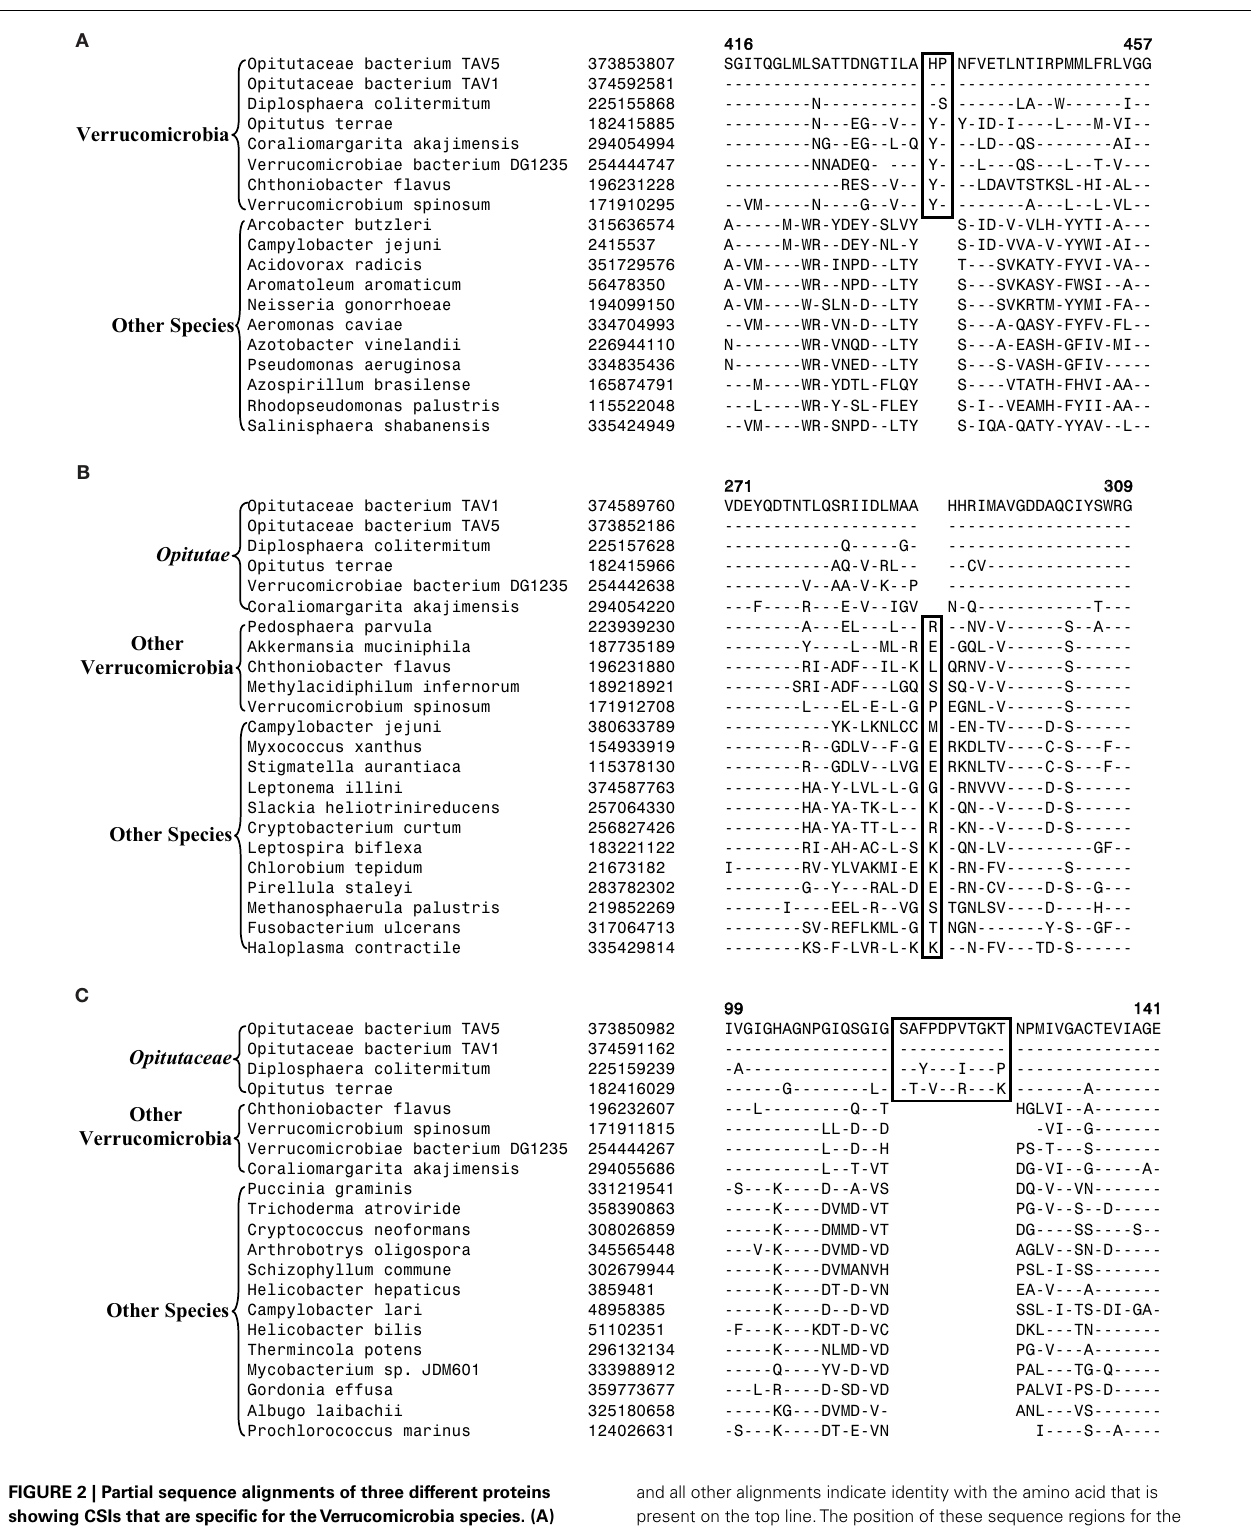
and all other alignments indicate identity with the amino acid that is present on the top line.The position of these sequence regions for the species on the top line is noted above the sequence. Except for the indicated groups ofVerrucomicrobia, these CSIs are not present in any other species in the top 250 Blastp hits. Sequence information for only limited number of species from other phyla of bacteria are shown in the alignments.The GenBank identifier (GI) numbers for different proteins are shown in the second